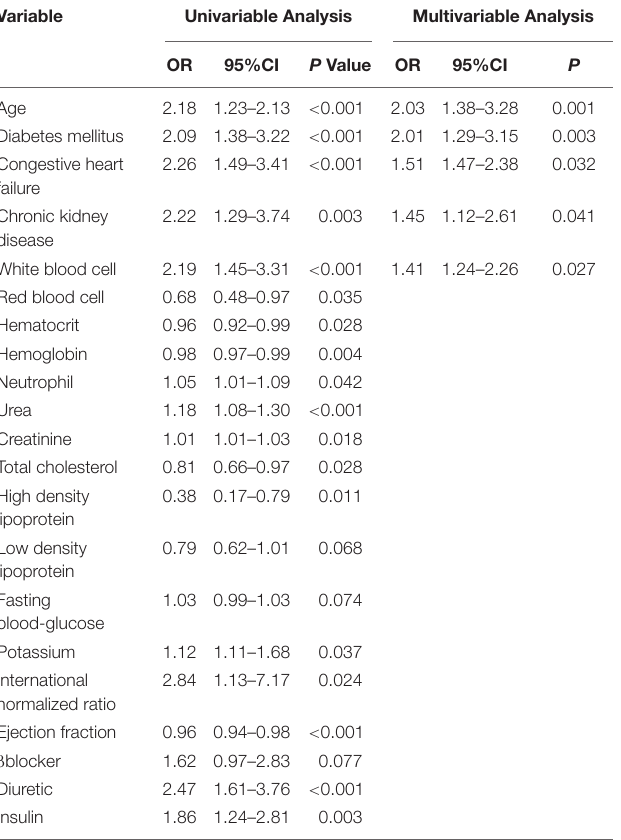
TABLE 2 | Univariate and multivariable logistic regression analysis of risk factors that were selected to develop the risk model for predicting thrombocytopenia (developmental data set).